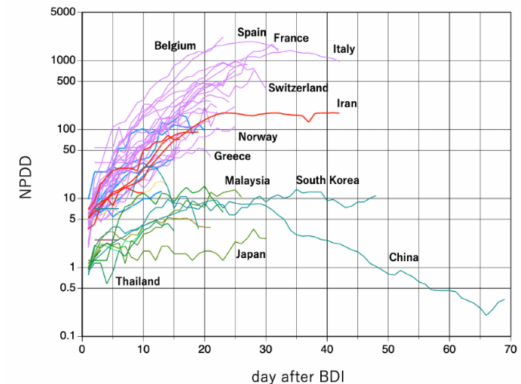
Figure 5. Time courses of NPDD after BDI by COVID-19. Green, red, blue, and purple lines represent Asia, the Middle East, Latin America, and Western countries, respectively. Some noticeable countries are labeled but refer to Figures 2 and 3 to identify each country. NPDD: number of population-adjusted daily deaths. BPI: beginning of the test-positive cases